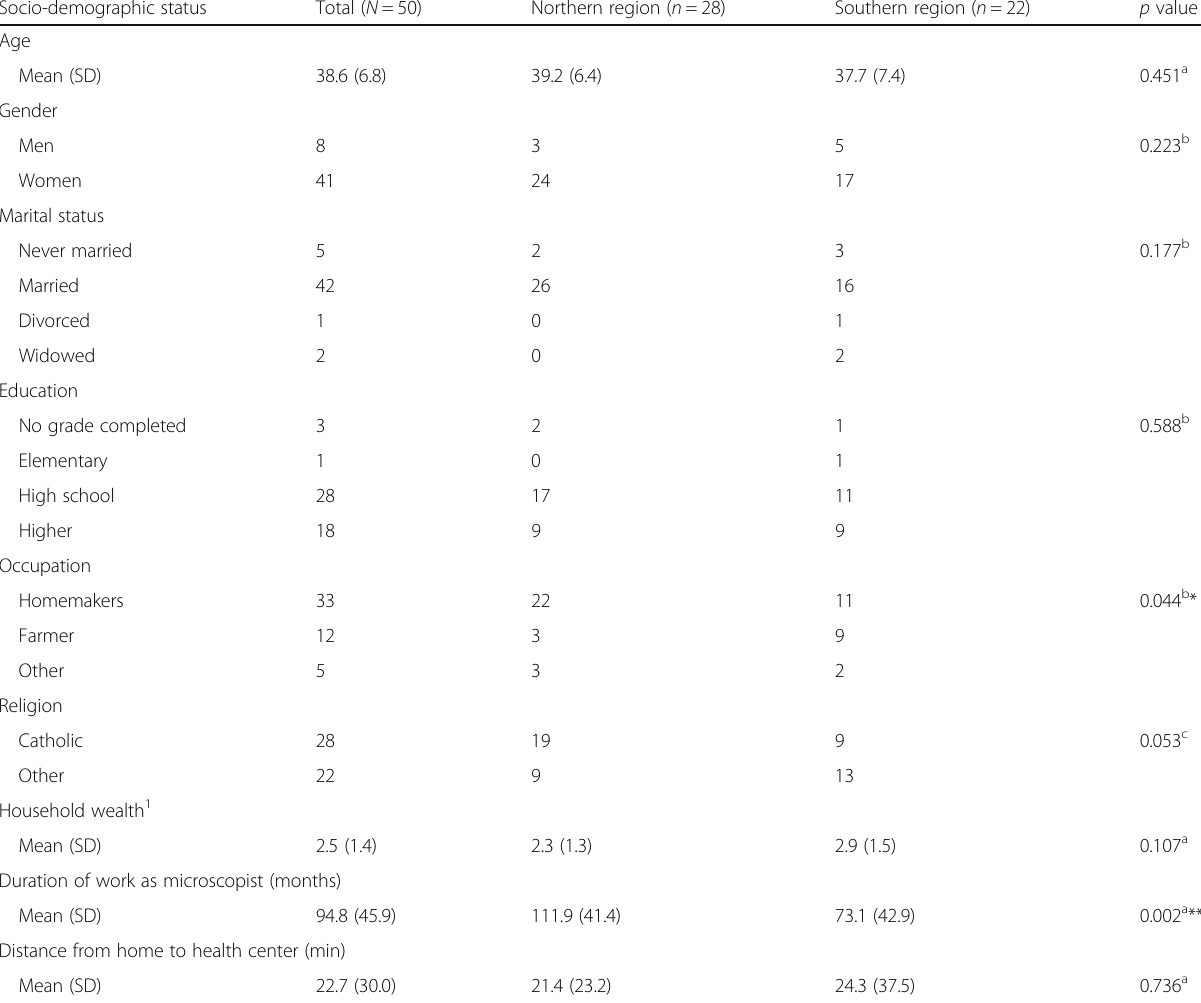
Table 2 Socio-demographic status of participants with respect to place of assignment Socio-demographic